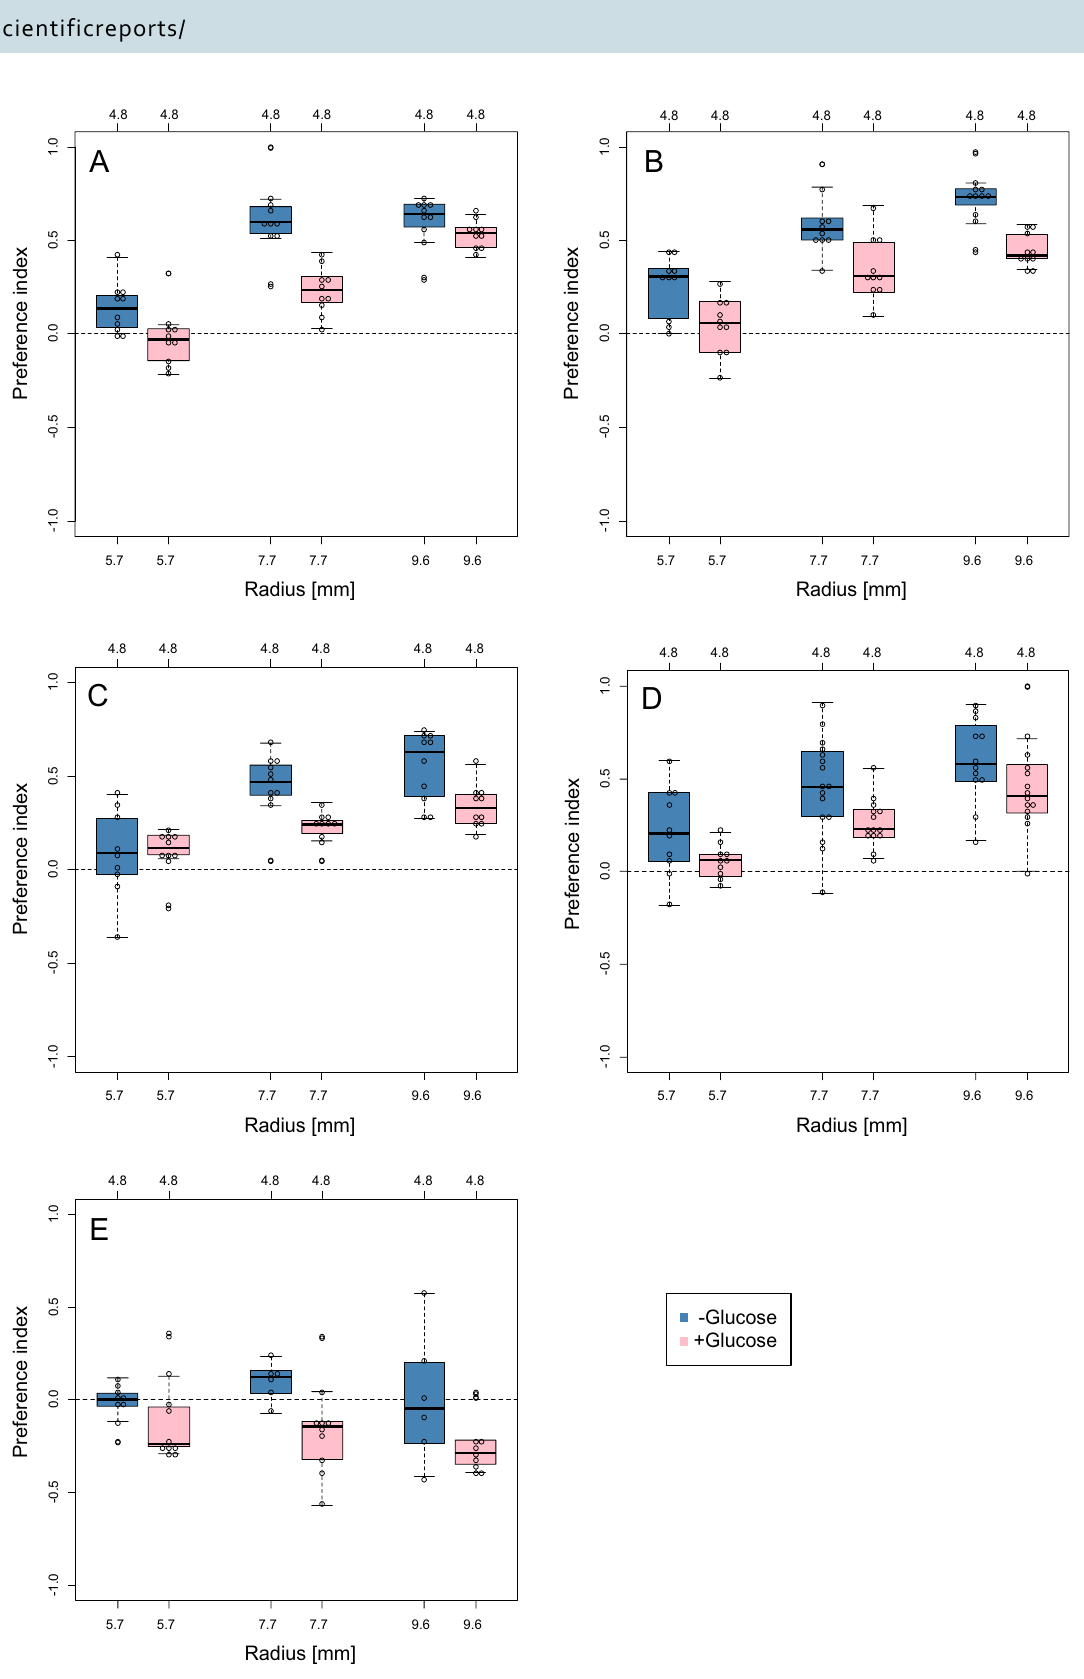
Figure 4. Results of the two-choice assay. ( A – D ) D. suzukii strains #17, #20, #22, and #26, respectively. ( E ) D. melanogaster CS. The x axis indicates the radius of the larger substrates. The smaller substrates were fixed as 4.8 mm. Preference index = (Number of eggs laid on smaller substrates − Number of eggs laid on larger substrates) ÷ Total egg number. Positive values of the preference index indicate the preference for a smaller